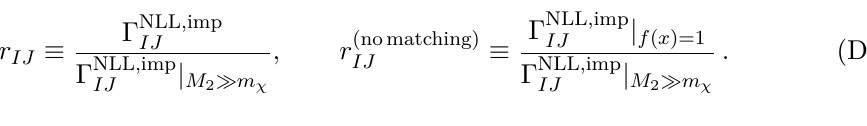
Figure 3 . Ratio r of the diagonal lightest-chargino annihilation matrix element in Γ NLL ,imp heavy-wino limit (approximated by M 2 = 4 M 1 ) when varying M 2 in benchmark